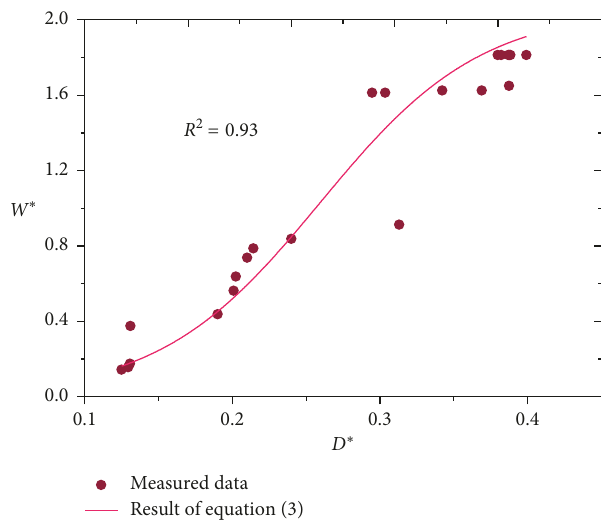
Figure 15: The dimensionless breach width and depth of the Tangjiashan natural dam. The points in the figure are the field data recorded during Tangjiashan natural dam failure process. The fitting curve is the simulated results of equation (3).